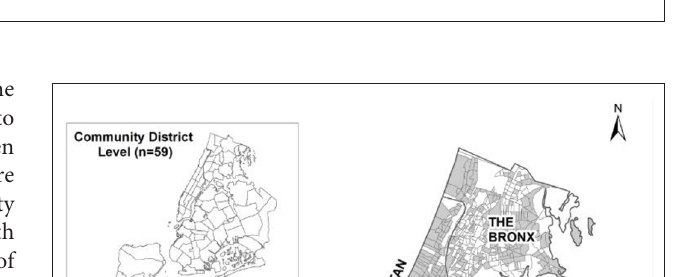
FIGURE 1 | The methods and process flow for this study.